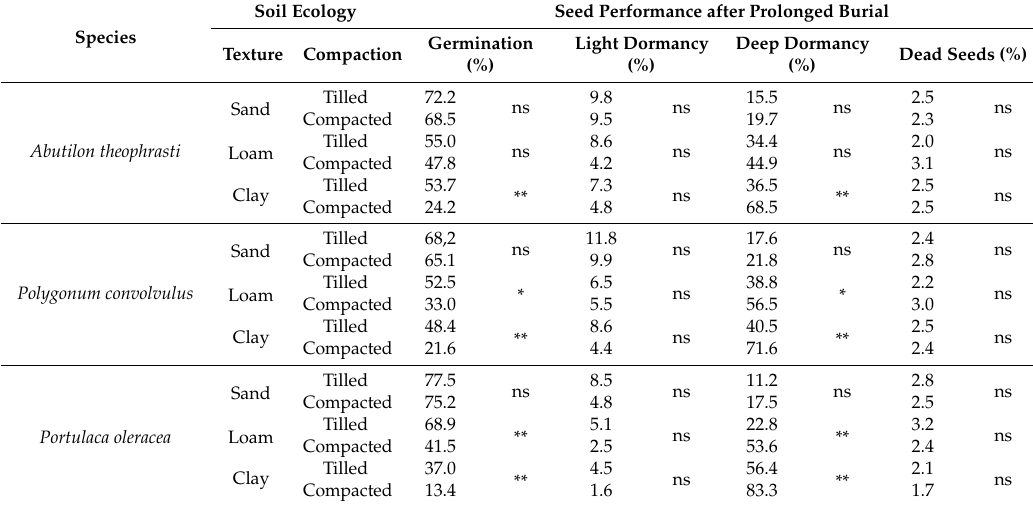
Table 3. Exhumed seed germination and dormancy performances of the three weed species as a function of soil texture and compaction during prolonged burial (six months at 8 cm depth). Single or double asterisks indicate, for each data pair, significant differences in the means (for p < 0.05 and p < 0.01, respectively, ns = not significant) in the Student Neumann Keuls (SNK) test.